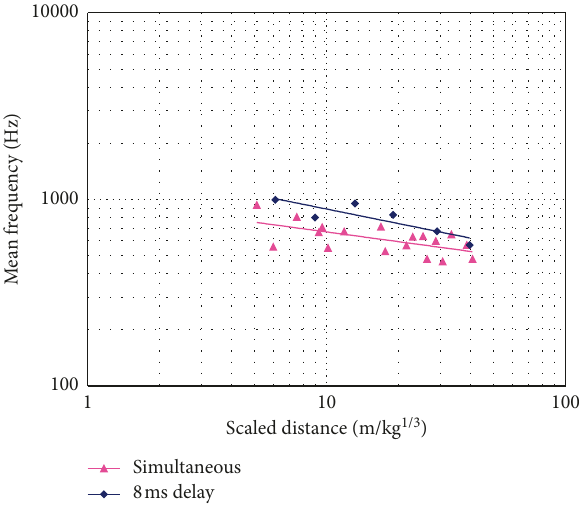
Figure 10: MFs between simultaneous blasting and short-delay